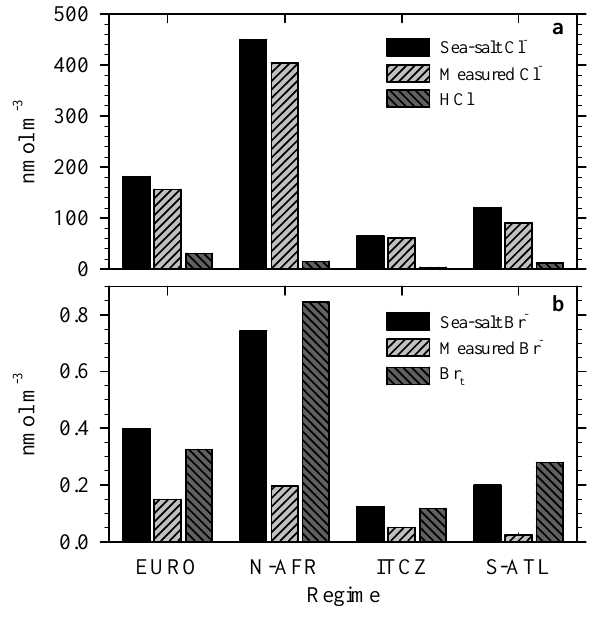
for each regime cal- 4